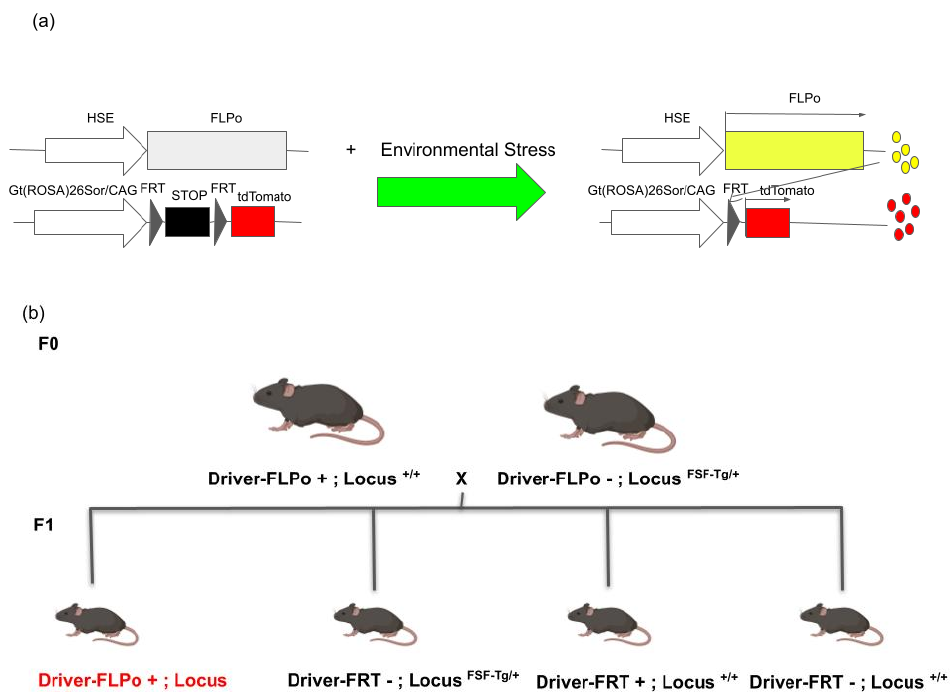
Figure 1. Approaches for lineage tracing of stressed cells in mouse models. ( a ) Schematic showing transgenic constructs of Flippase-FRT system by which stressed cells can be continuously monitored after Heat Shock signal activation. ( b ) Suggested mating strategy. To avoid germinal recombination, which can confound accurate cell lineage tracing, the recombinase-containing transgenic mouse line needs to be separately maintained until crossing with the reporter-transgene-containing mouse line for lineage tracing experiments. F0 and F1 are parent and offspring animals, respectively. The F1 animal highlighted in red can be used for the experiment. FSF-Tg: